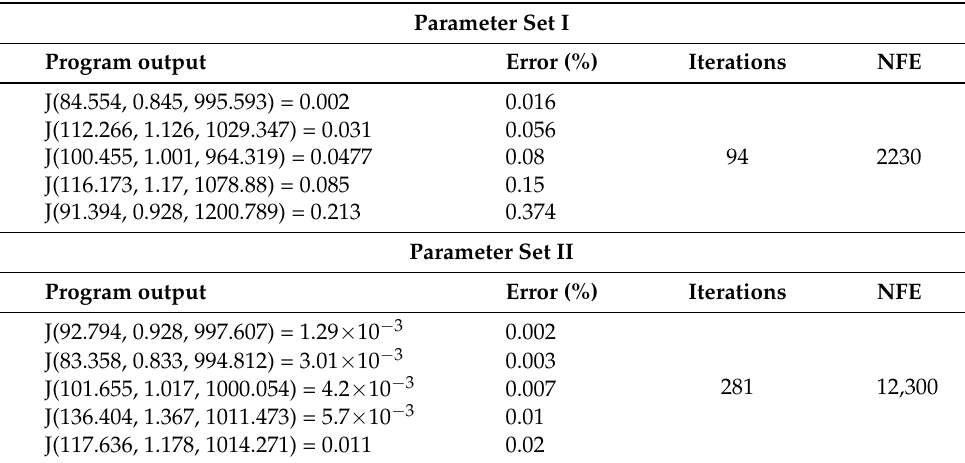
Table 9. Results for the reaction-dominated case.